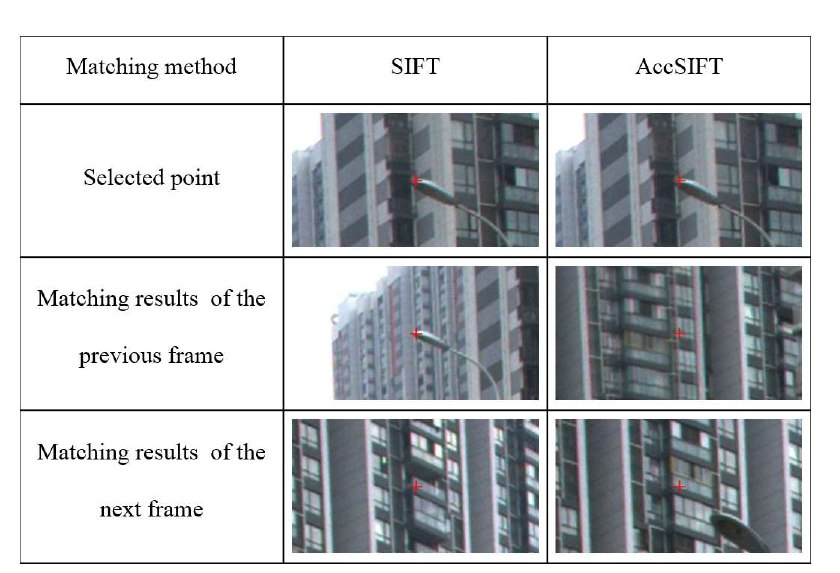
Figure 11. Comparison of the SIFT and the AccSIFT descriptors on matching of the Wuhan images.